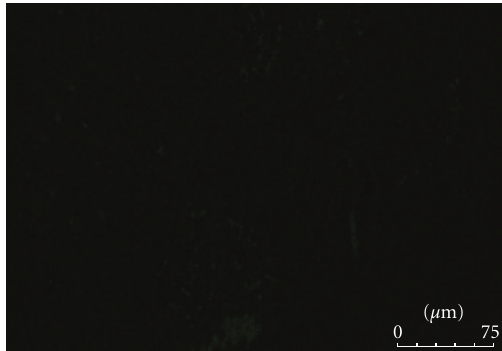
Figure 9: Immunofluorescence staining for CD25 in a lymph node medulla in a control mouse.